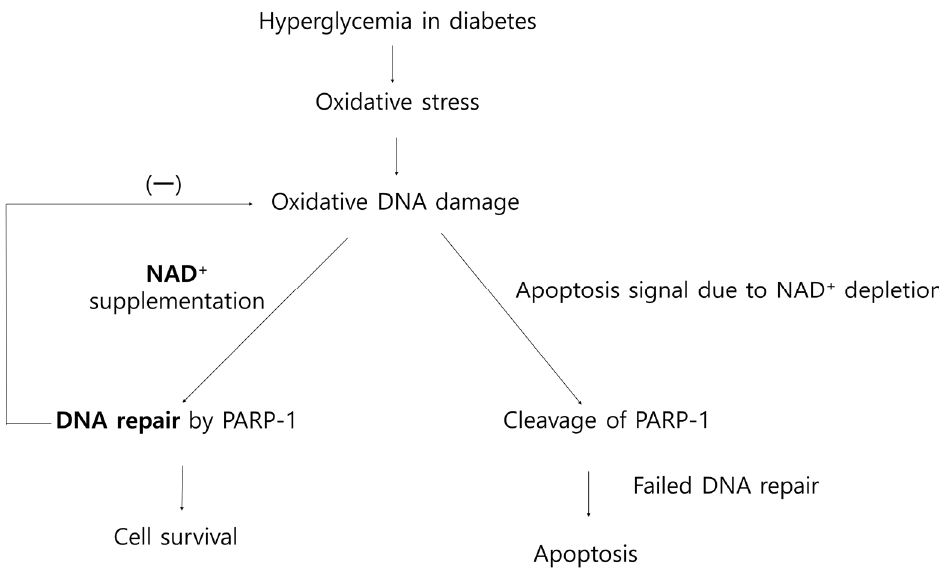
Figure 10. Hypothetical overview of oxidative DNA damage, DNA repair, and effects of nicotinamide (precursor of NAD + ) supplementation on retinal neurodegeneration.